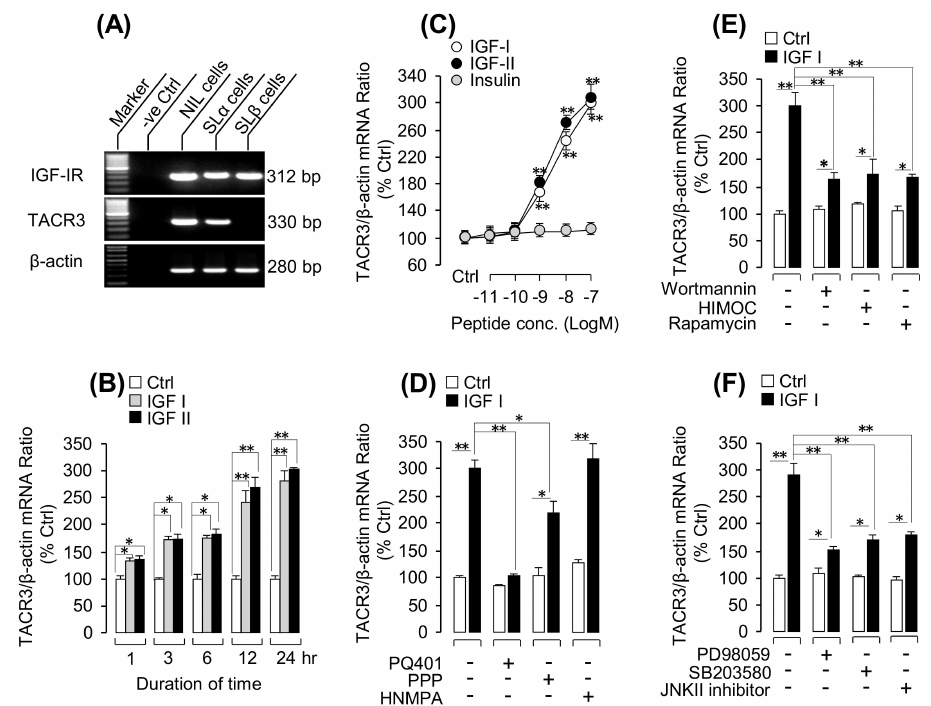
Figure 3. Insulin-like growth factors (IGF)-I / -II-induced TACR3 mRNA expression in grass carp pituitary cells: ( A ) Cell-type specific expression of grass carp TACR3 and IGF-IR in grass carp pituitary cells. By using the laser capture microdissection (LCM) technique, immuno-identified SL α cells and SL β cells were isolated from grass carp pituitary cells; then, these specific cell groups were subjected into RT-PCR with specific primers for TACR3 and IGF-IR. In this study, RT-PCR of TACR3 and IGF-IR in mixed NIL pituitary cells were used as a positive control while RT-PCR for β -actin was used as internal control. ( B ) Time course of human IGF-I (100 nM) and IGF-II (100 nM) treatment on TACR3 mRNA expression in grass carp pituitary cells; ( C ) dose-dependence of 24-h treatment with increasing levels of IGF-I, IGF-II, and insulin (0.01–100 nM) on TACR3 mRNA expression; and ( D ) receptor specificity